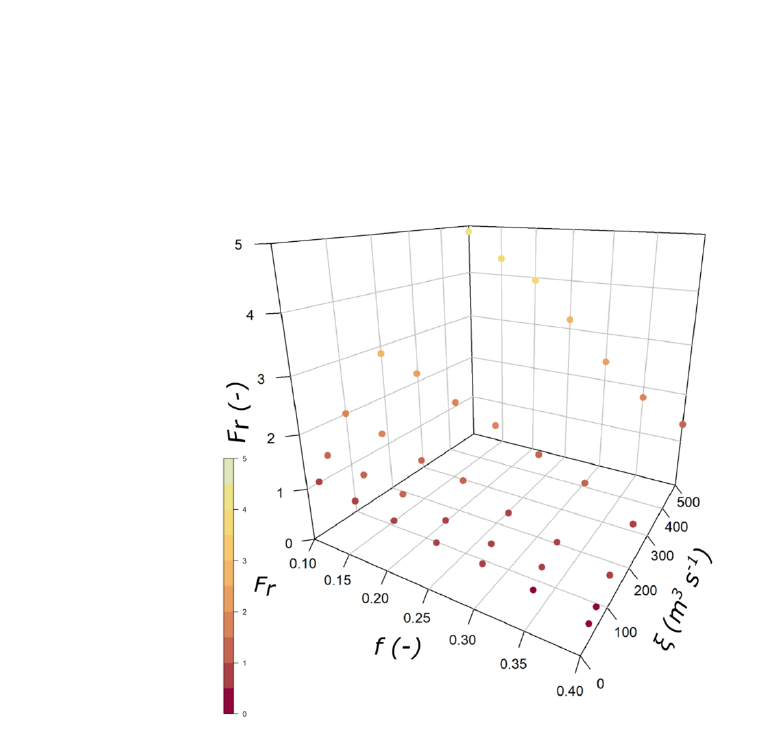
Figure A5. Froude number at the peak discharge at x = 1000m for the cases with Q p = 2940m 3 s − 1 .